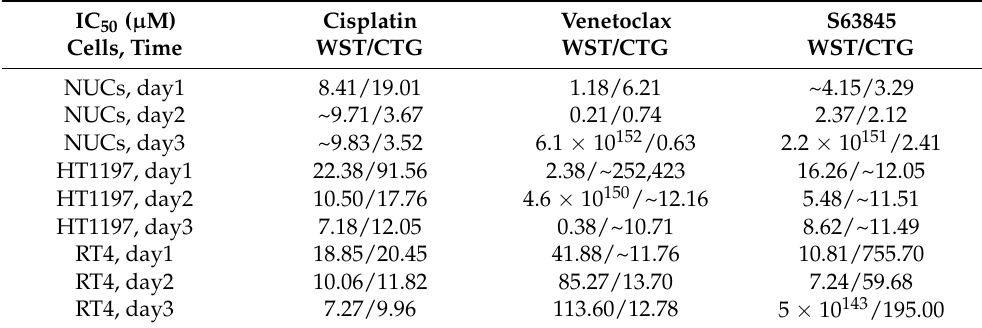
Table 1. Half maximal inhibitory concentrations of CIS, VTX, and S63 in urothelial cells in adherent culture explored by two different viability assays 1